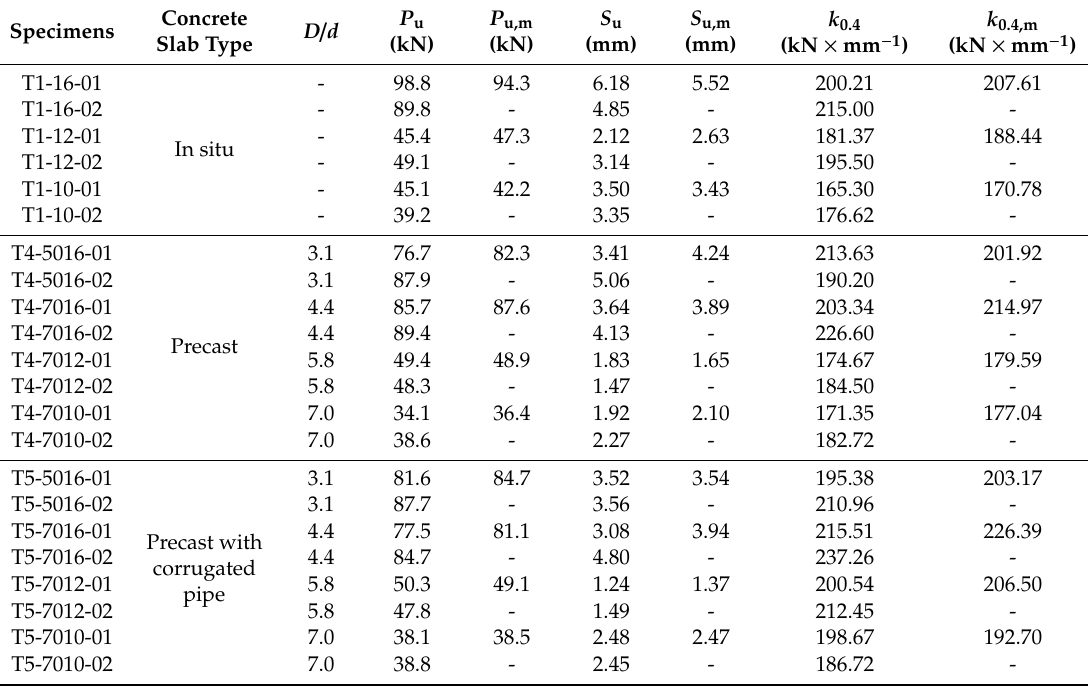
Table 3. Test results for each per connector specimen.